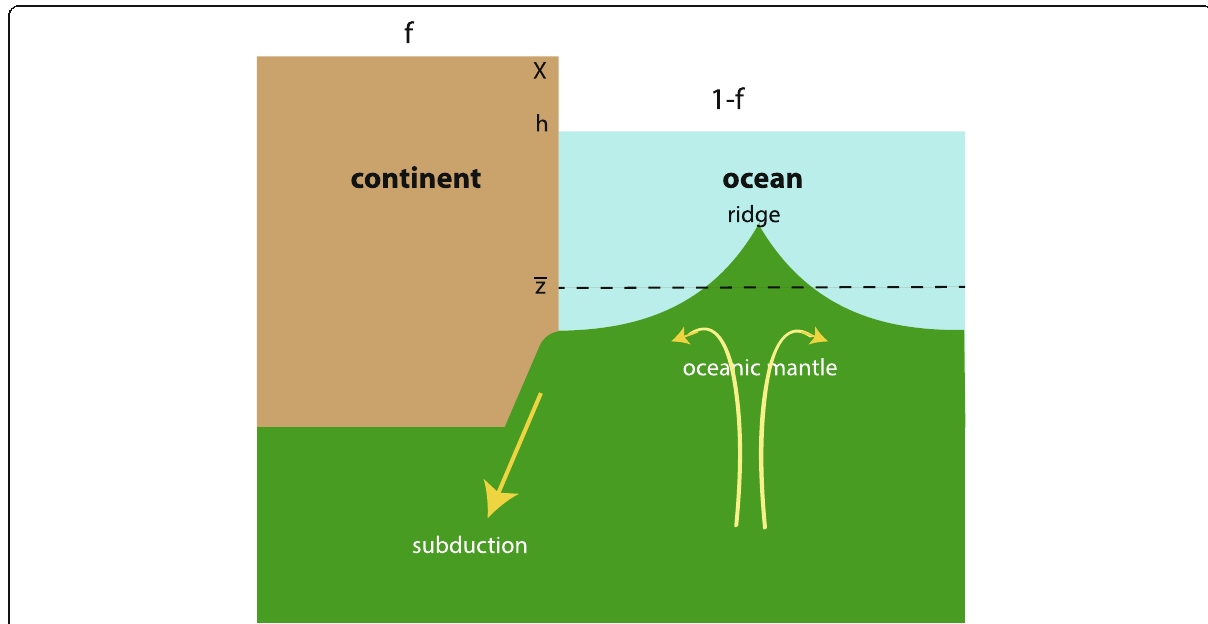
Fig. 7 A cartoon illustrating the factors affecting the sea-level (from Karato 2015). h : the sea-level, f : areal fraction of continents, z : the mean depth of the ocean that depends on the mean age of the ocean floor, X : height of the continental margin that depends on the dynamic topography determined by the mantle